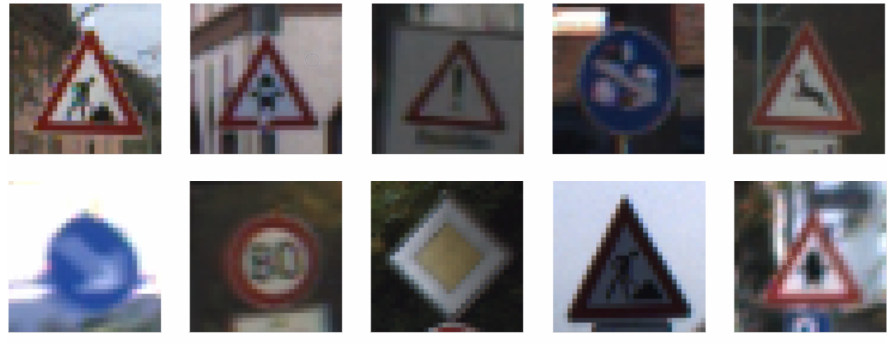
Figure 5. Examples of images from GTSRB.